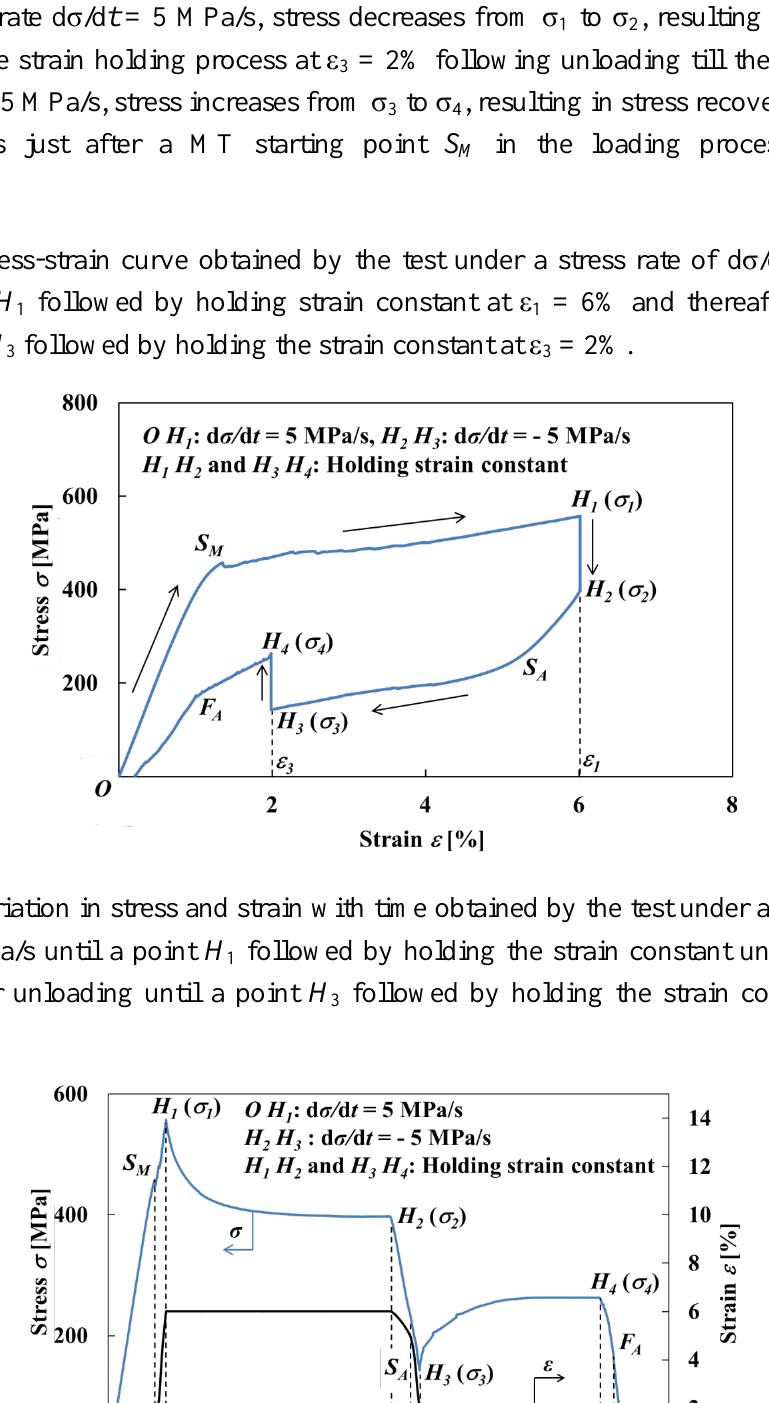
= 6% and thereafter unloading 1 = 2%. 3